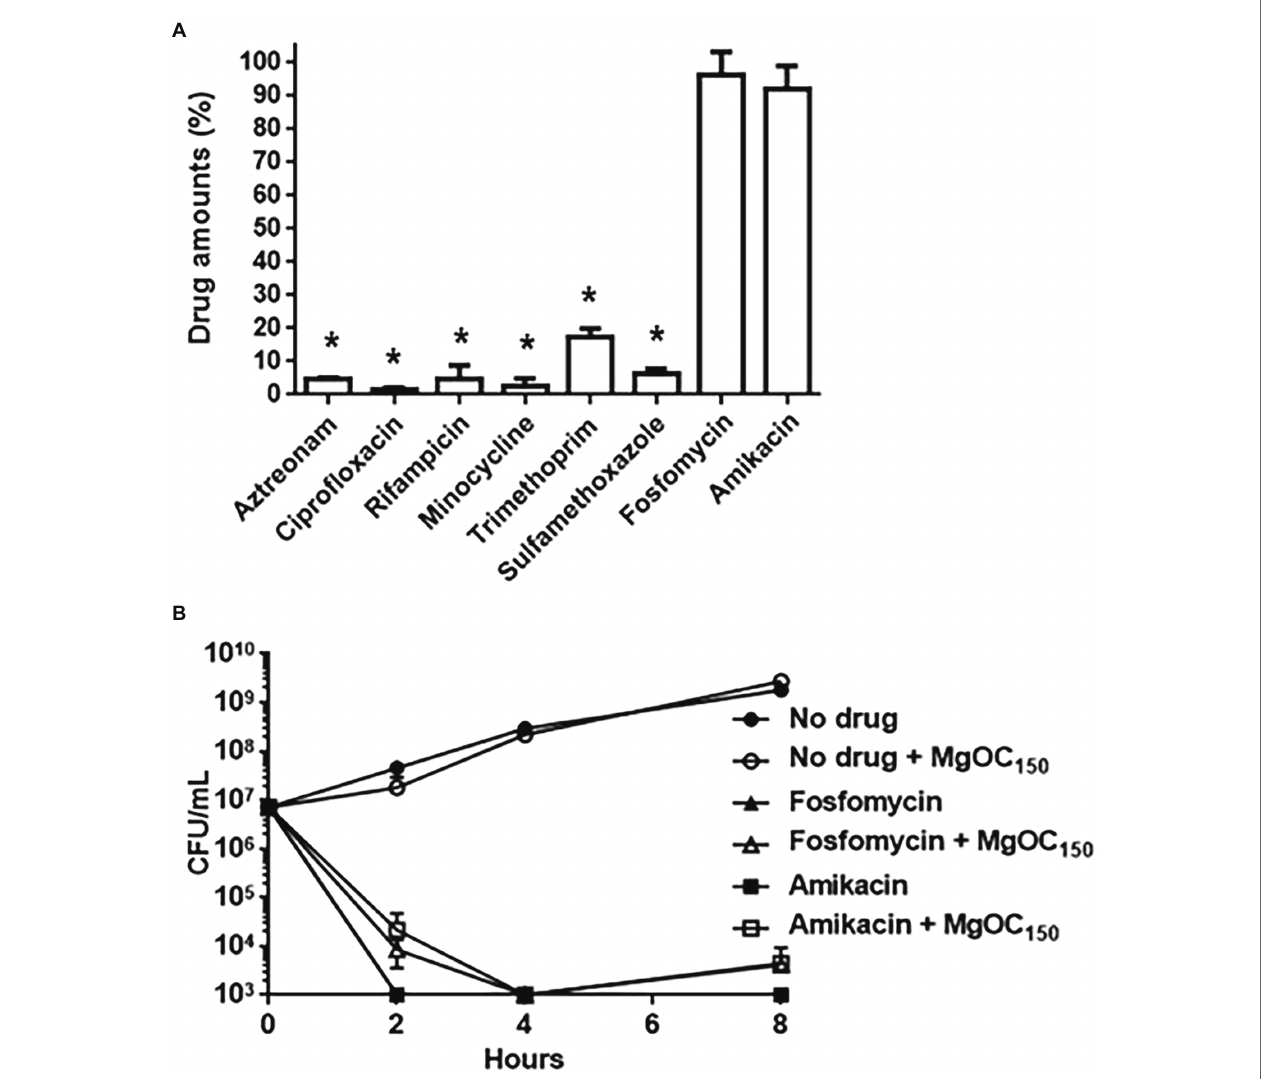
FIGURE 7 | Antimicrobial activities of indicated drugs in the presence of by MgOC 150 . (A) Drug adsorption by MgOC 150 . Each drug was incubated in an aqueous solution with and without 30 mg MgOC 150 for 2 h. The y axis shows the percent of drug amount (mg) after incubation with MgOC 150 relative to the drug amount (mg) after incubation without MgOC 150 . (B) Growth of the EHEC strain when cultured with or without indicated drugs in the presence and absence of 30 mg MgOC 150 . Data plotted are the means from three independent experiments; error bars indicate the standard deviations. Asterisks denote significance for values ( p < 0.05) of drug amount and CFU (colony-forming unit) after incubation with MgOC 150 relative to that after incubation without MgOC 150